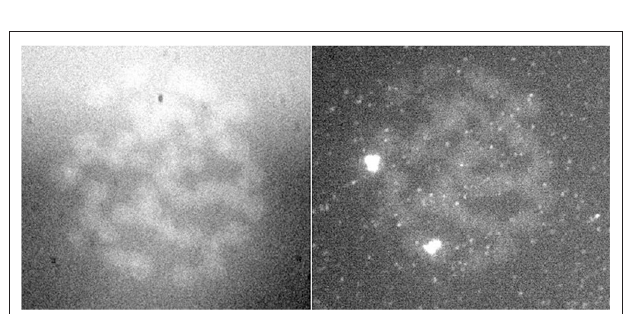
FIGURE 7 | FISH signal of the same preparation in two different wavelengths ( Jovanovi ´ c, 2001; Jovanovi ´ c et al., 2014).